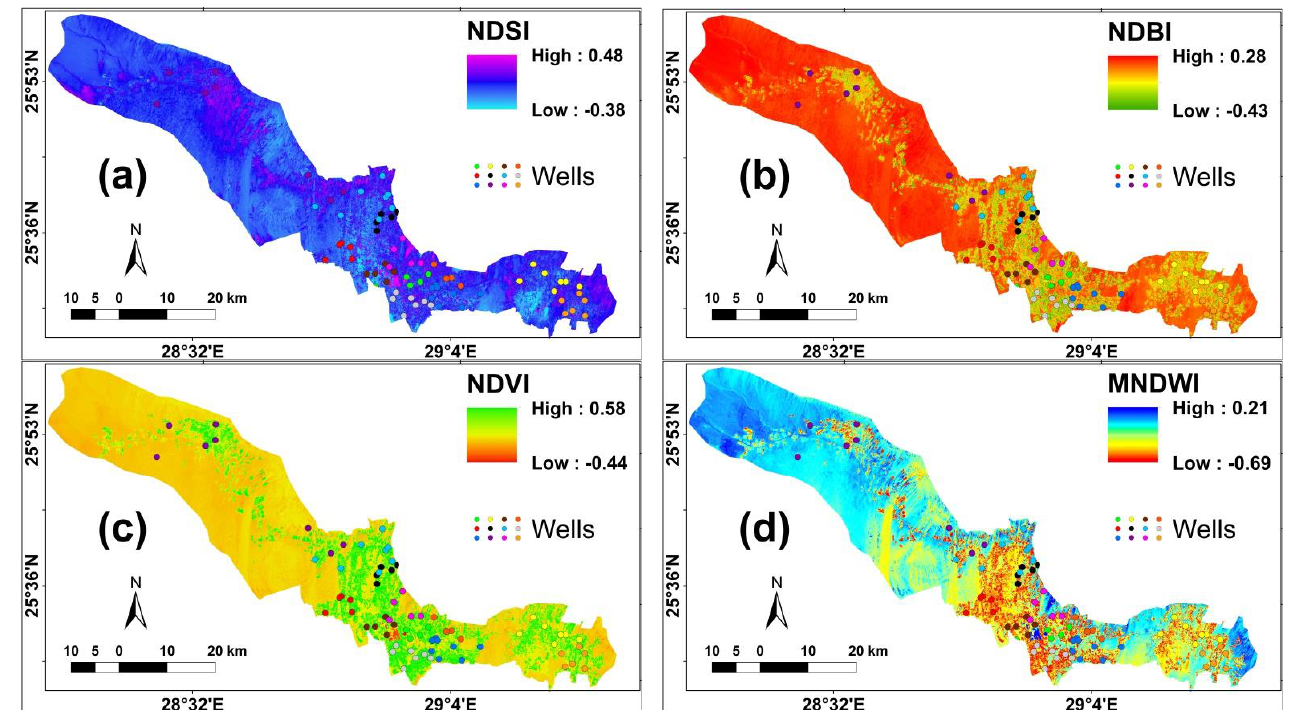
Figure 4. Land use/cover map of the area under investigation.